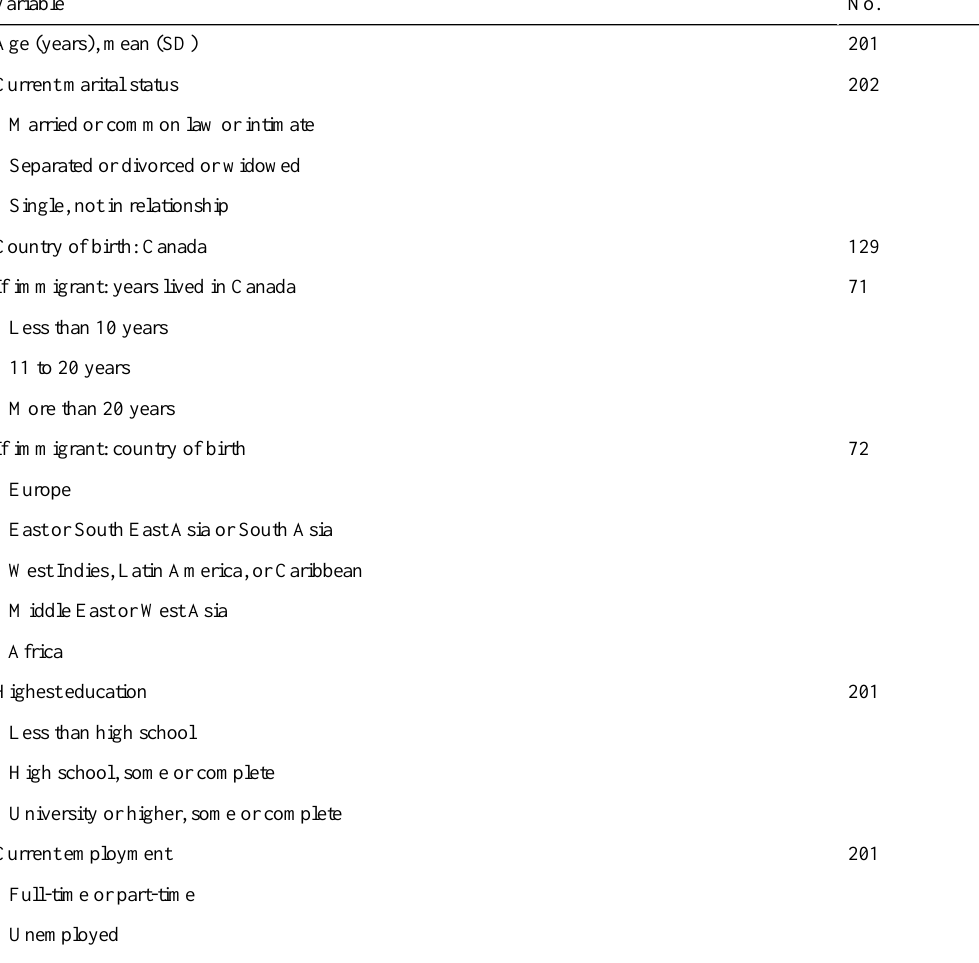
Table 1. Sociodemographic characteristics (N = 202)